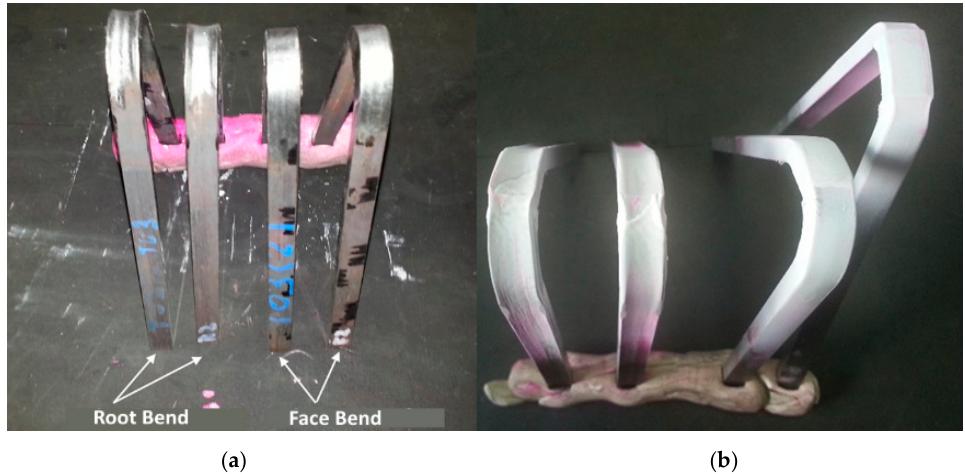
Figure 11. Samples subjected to bending tests: ( a ) samples bent in face and root surfaces, and ( b ) liquid penetrant technique applied to bent samples.